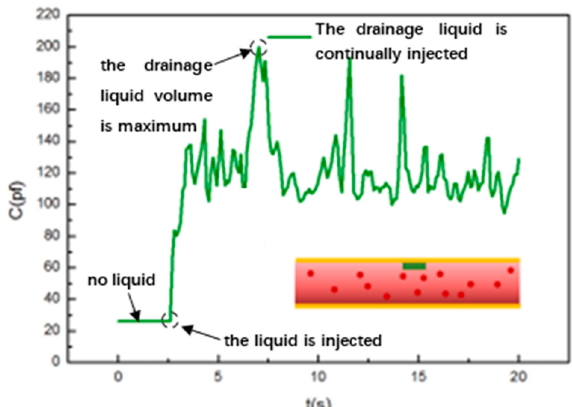
Figure 6. The capacitance output curve of the sensor when the entire pipeline is unobstructed and the drainage liquid is continuously discharged.